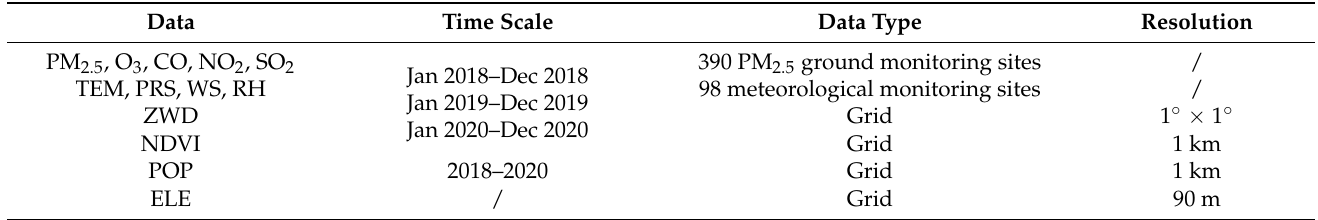
Table 1. Research database information introduction. In the table, TEM indicates temperature, PRS indicates barometric pressure, WS indicates wind speed, RH indicates relative humidity, POP indicates population size, and ELE indicates elevation. The table shows the spatiotemporal resolution and data types of different experimental